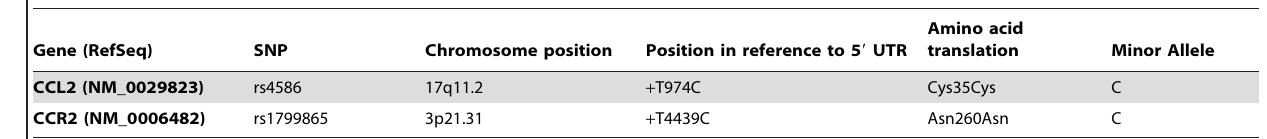
Table 1. Description of SNPs genotyped.